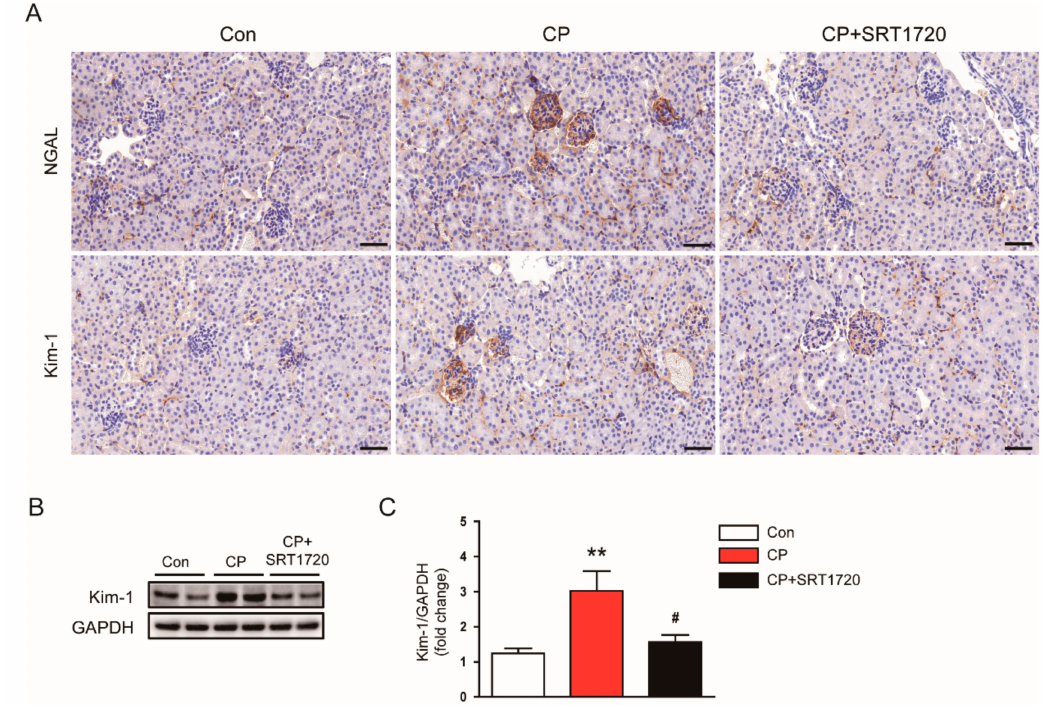
Figure 3. E ff ects of SRT1720 on renal expression of neutrophil gelatinase-associated lipocalin (NGAL) and kidney injury molecule-1 (Kim-1) in mice treated with cisplatin. ( A ) Representative images of immunohistochemical staining using anti-NGAL or anti-Kim-1 antibody. Scale bar: 50 µ m. ( B ) Western blots of Kim-1 level in kidneys. ( C ) Quantification of Kim-1 level. ** p < 0.01 vs. Con. # p < 0.05 vs.